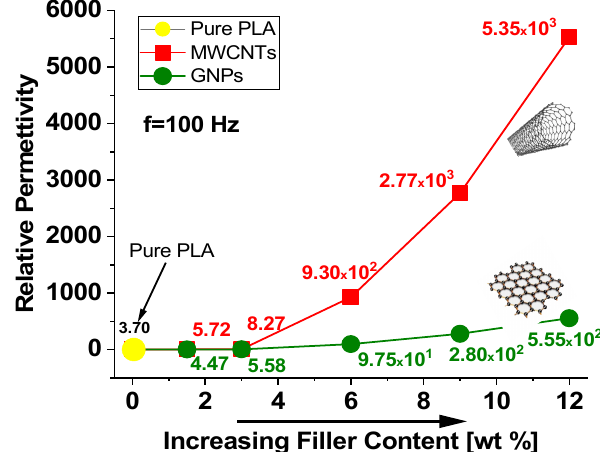
Figure 16. Relative permittivity (at 100 Hz) as function of filler concentration for PLA reinforced with MWCNTs and GNPs.